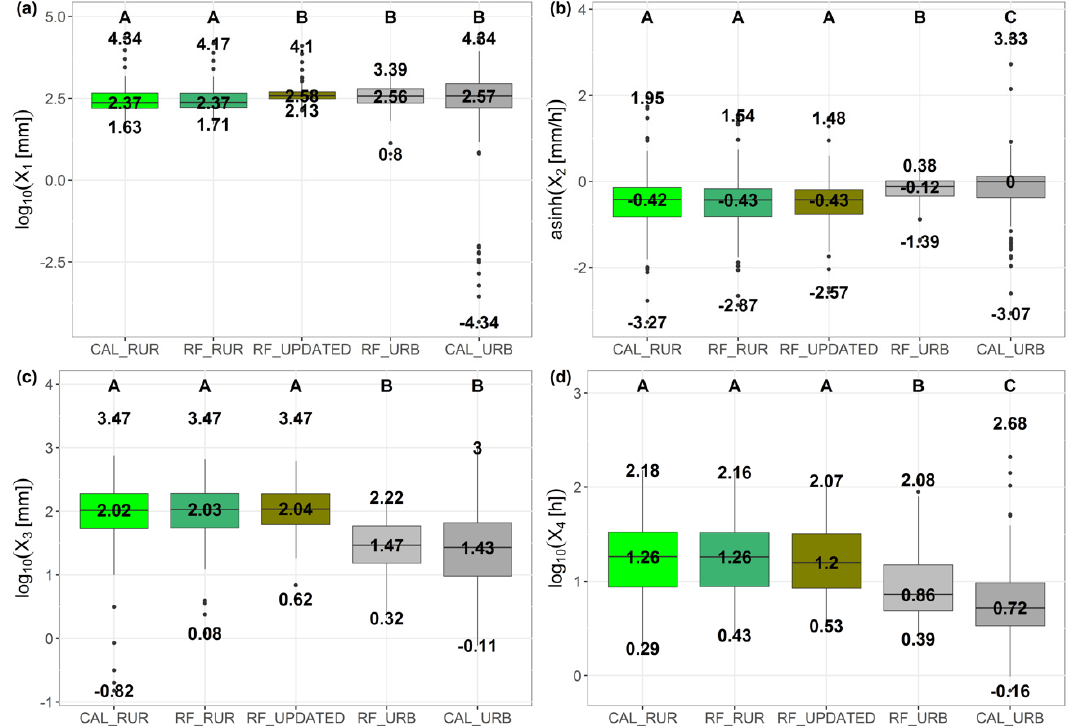
Figure 8. Distribution of parameters ( a ) X 1 , ( b ) X 2 , ( c ) X 3 , and ( d ) X 4 with values indicating the minimum, the median, and the maximum. CAL_RUR are the rural calibrated parameters (with respect to KGESR), RF_RUR are the RF-estimated rural parameters, RF_UPDATED are the RF-estimated parameters over the rural sample with transferred CPD value from the corresponding urban catchment, RF_URB are the RF-estimated parameters over the urban sample, and CAL_URB are the calibrated parameters (with respect to KGESR). The letters indicate statistical equality at 5% risk between the different parameter distributions, estimated using the Mann–Whitney–Wilcoxon test.